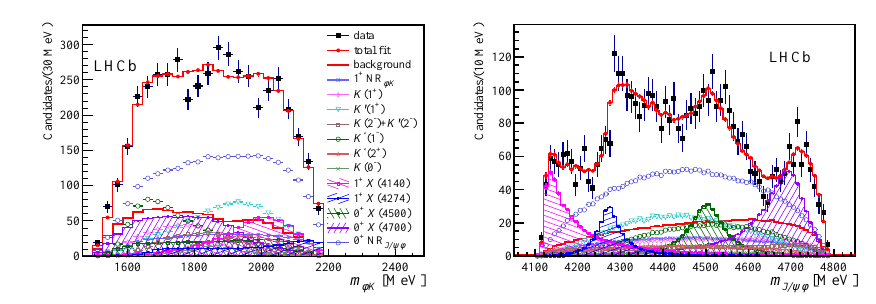
Figure 3. Distributions of (left) φ K + , (right) and (right) J /ψφ invariant masses for B + → J /ψφ K + candidates (black data points) compared with the results of amplitude fit. The total fit is given by the red points with error bars. Individual fit components are also shown. The figure is taken from [19].